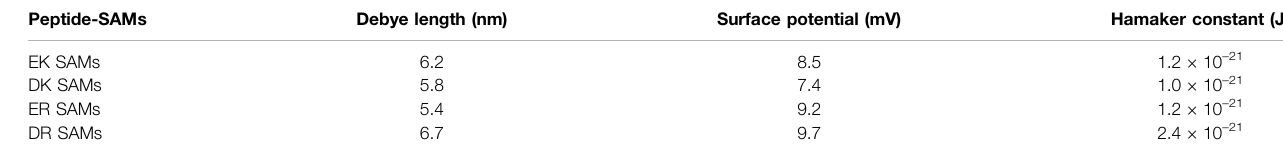
TABLE 6 | Estimated surface potential and Hamaker constant from force-separation curves between peptide SAMs in 1 mM PB. Peptide-SAMs Debye length (nm) Surface potential (mV) Hamaker constant